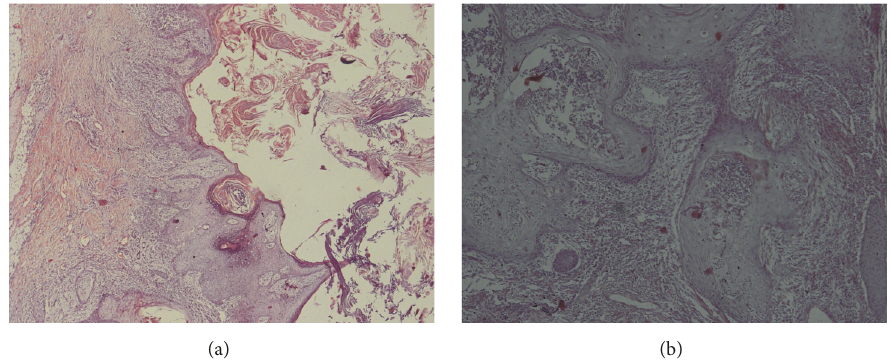
Figure 8: Well differentiated squamous cell carcinoma at low power ( × 40) (a) and high power ( × 100)